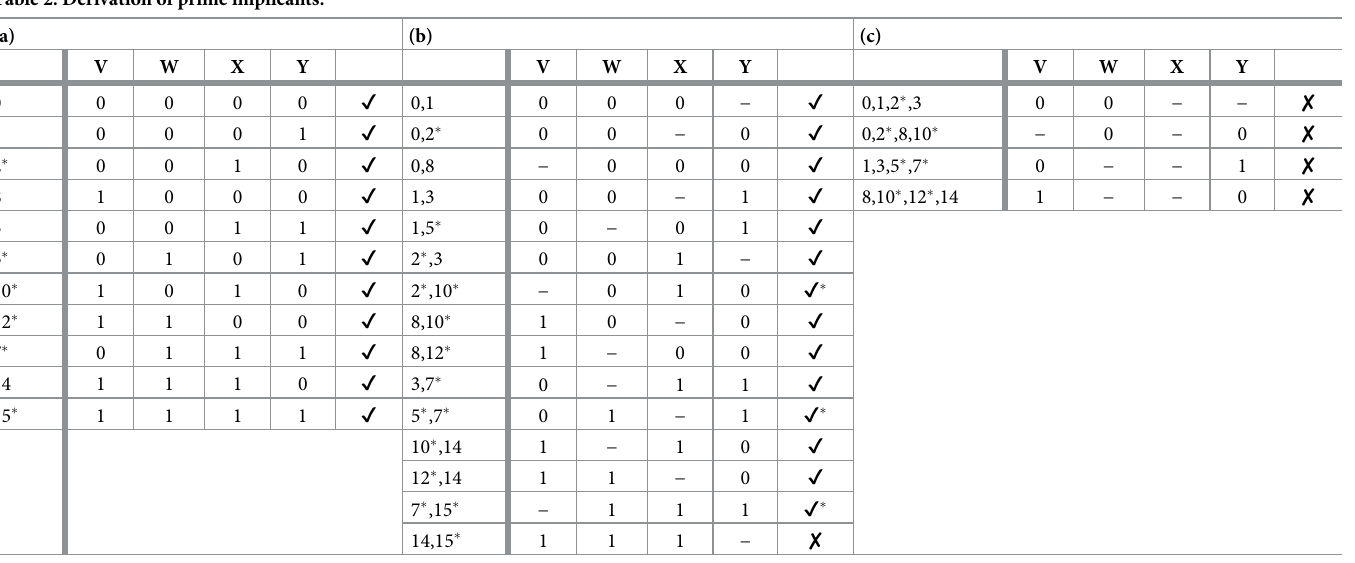
Table 2. Derivation of prime